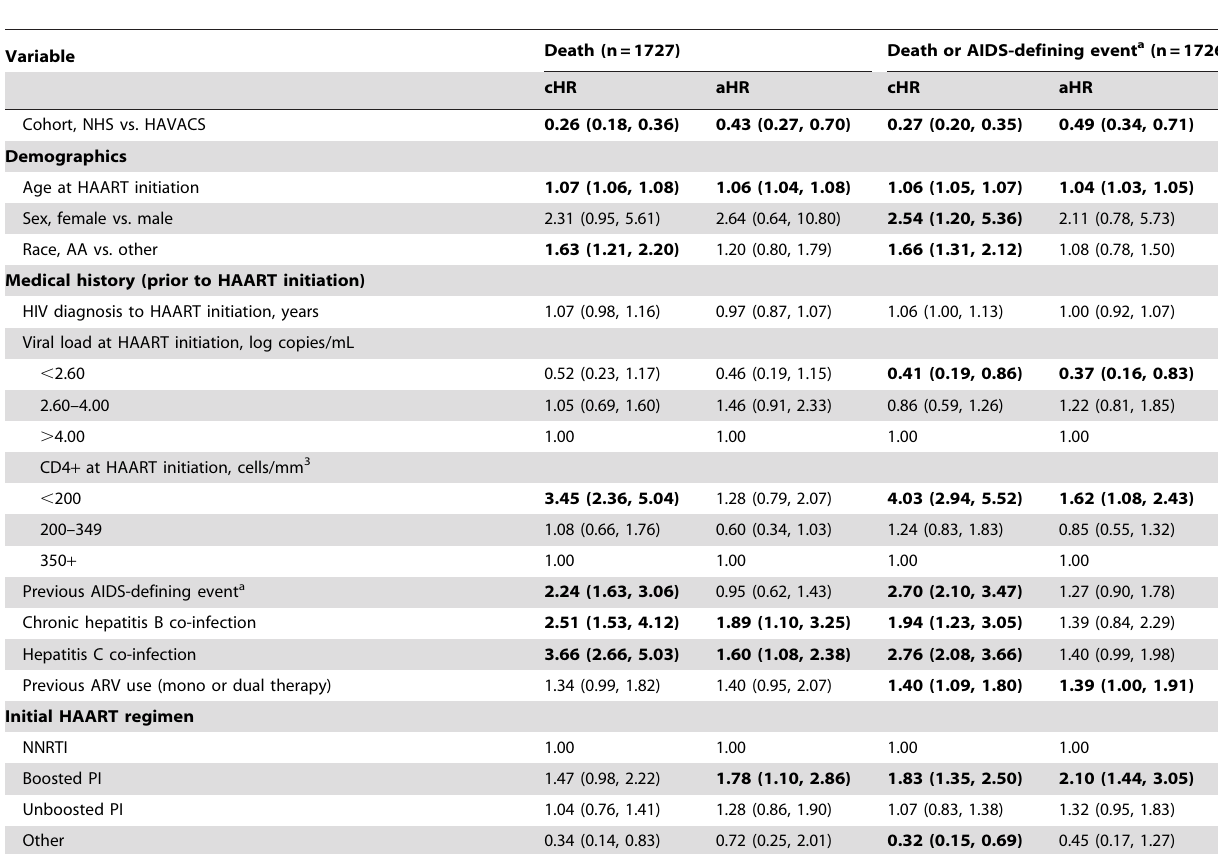
Table 2. Crude and adjusted predictors of time to development of outcomes after initiating HAART using Cox proportional hazards